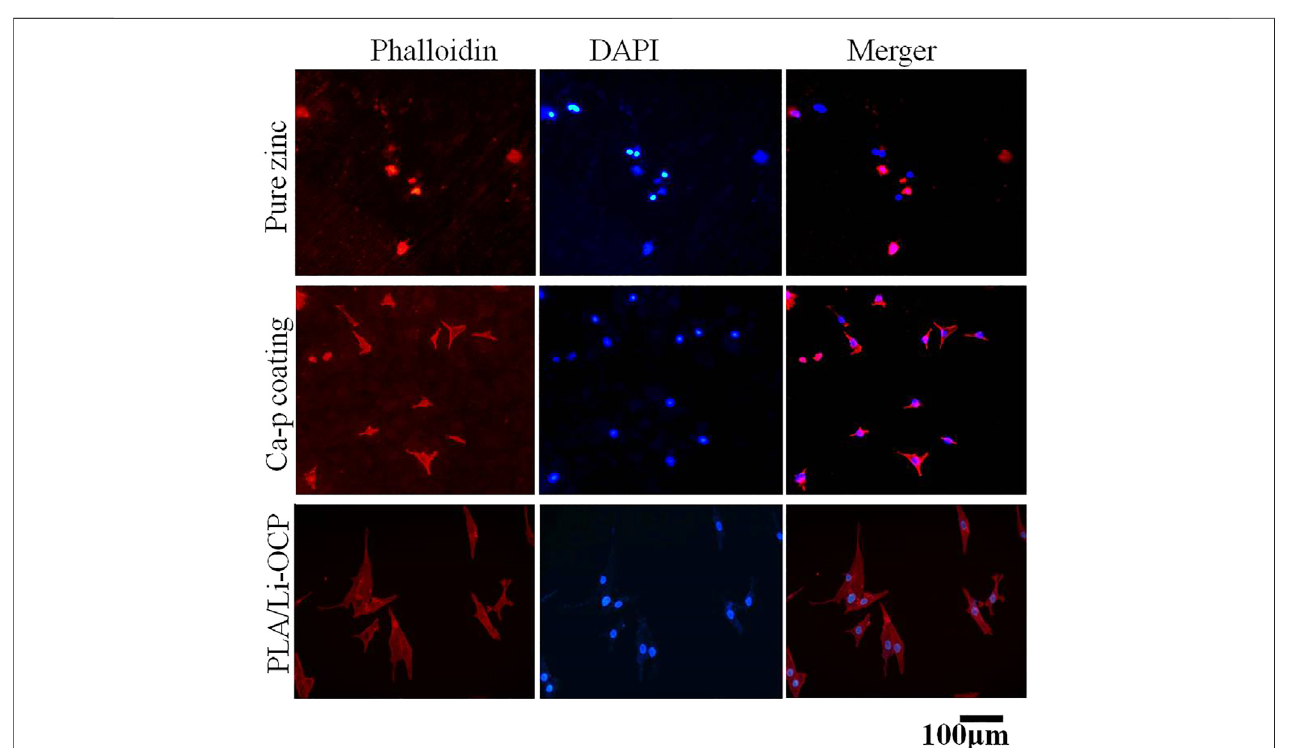
FIGURE 8 | Immuno fl uorescence-stained osteoblasts on samples after 3 days of culture.